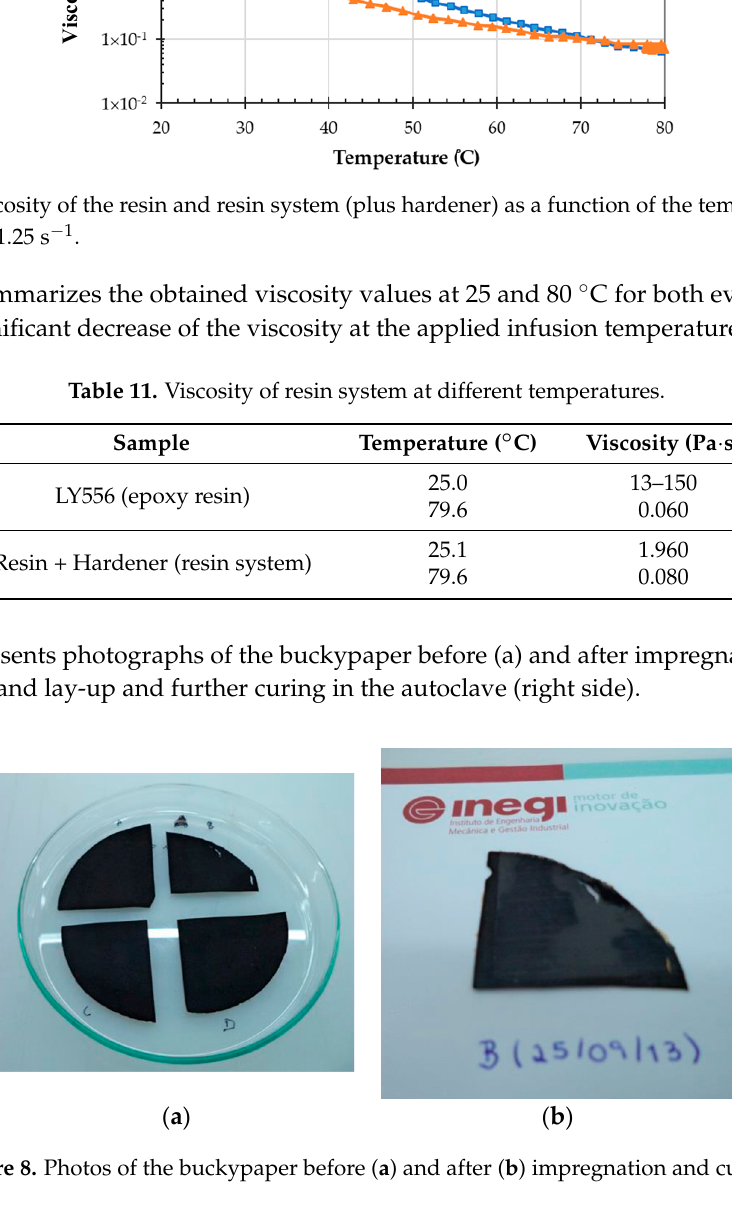
Table 12. Properties of manufactured CNT buckypaper samples.